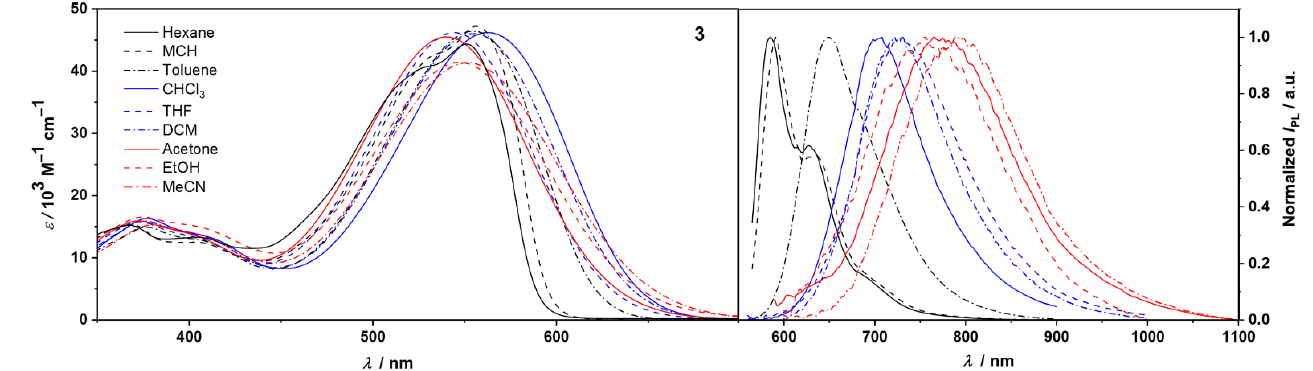
Figure 4. UV/Vis absorption spectra of 3 in solvents of varied polarity measured at c = 10 −5 M – 10 −6 M ( left ). Fluorescence spectra in solvents of varied polarity (colors according to relative permittivity ε r : black lines for ε r < 3; blue lines for 3 < ε r < 10; red lines for ε r > 10) determined by the optical dilution method (OD < 0.05) ( right ).